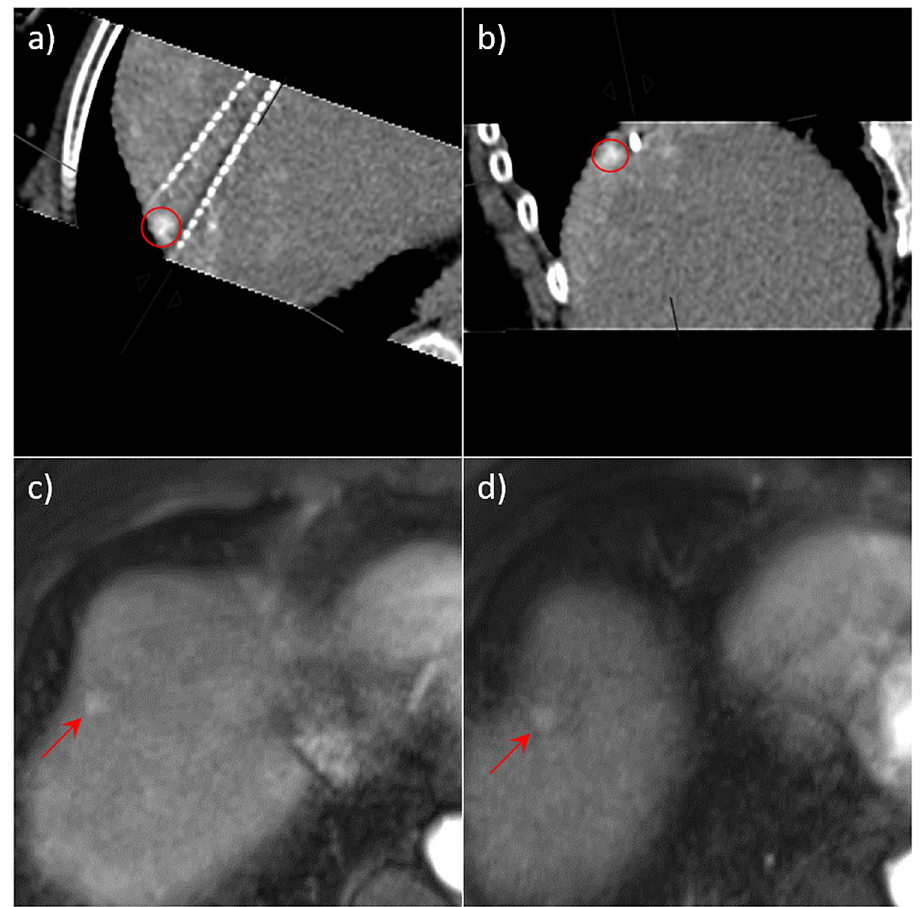
Figure 5. Another example of an IRE with residual tumor after ablation with 2 needles. ( a ) and ( b ) show MPRs of the CT with needle placement immediately before ablation, ( a ) in parallel alignment to the needle plane, ( b ) orthogonal to it. HCC, marked with lipiodol the day before, is outlined as red circle. In this case the depth of the lateral needle was insufficient due to the subcapsular location of the tumor (Ndep = 11 mm), the needle divergence was borderline high (Ndiv = 5.7°) and the tumor-center-to-ablation-center distance was too high (TACD = 8 mm). ( c ) Contrast-enhanced MRI before ablation with hyperarterialised HCC (arrow). ( d ) Residual tumor 6 weeks after